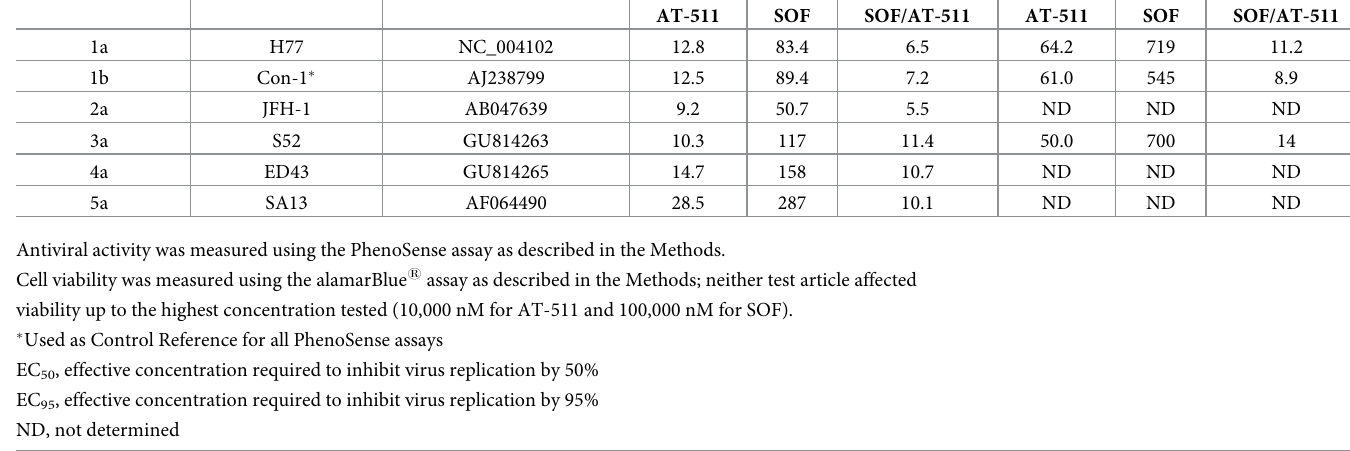
Table 1. Pan-genotypic antiviral activity of AT-511 in a panel of laboratory HCV replicons. HCV Genotype Reference